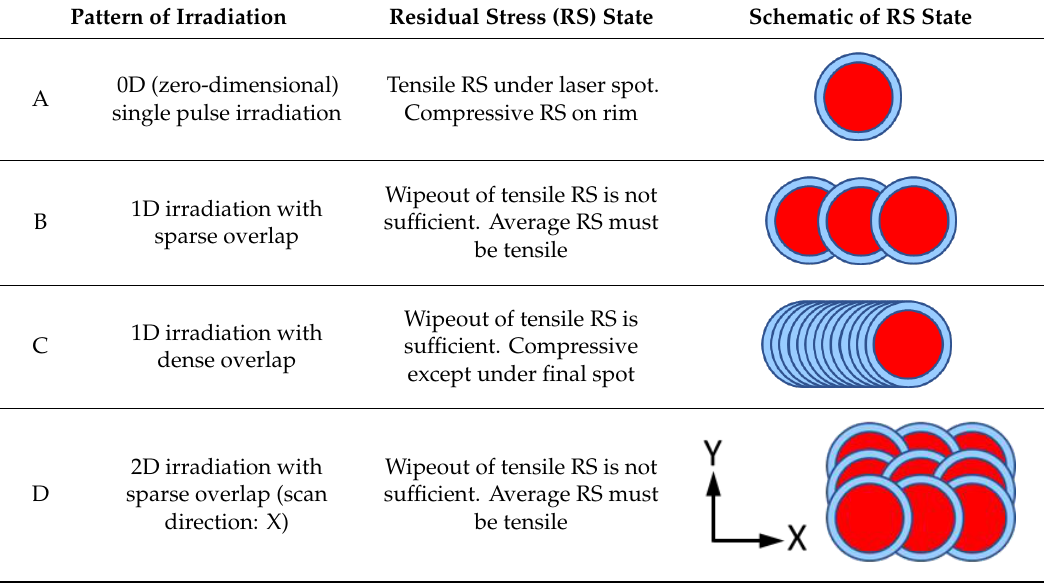
Table 2. Surface residual stress after 0D single pulse, 1D line, and 2D area irradiation with different overlaps. Blue and red colors represent compression and tension, respectively.